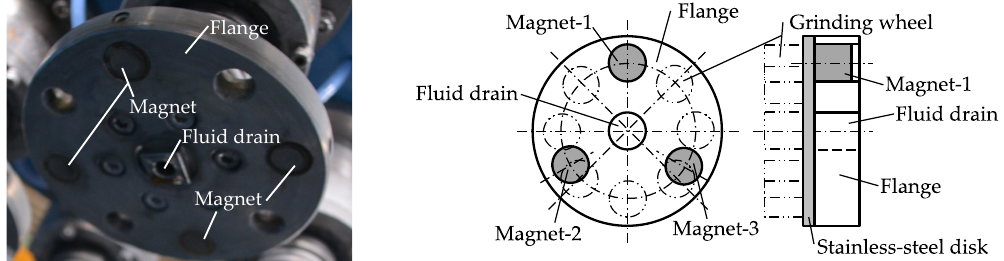
Figure 2. Magnet attachment and grinding fluid drain.